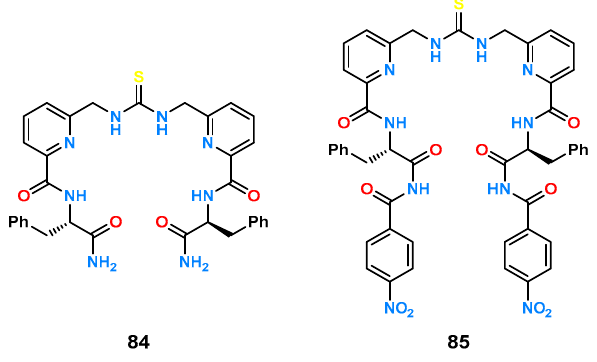
Figure 29. Hybrid receptors 84 and 85. Titrations under 1 H NMR control in a mixture of 10% DMSO- d 6 in CDCl 3 ( v / v ) of